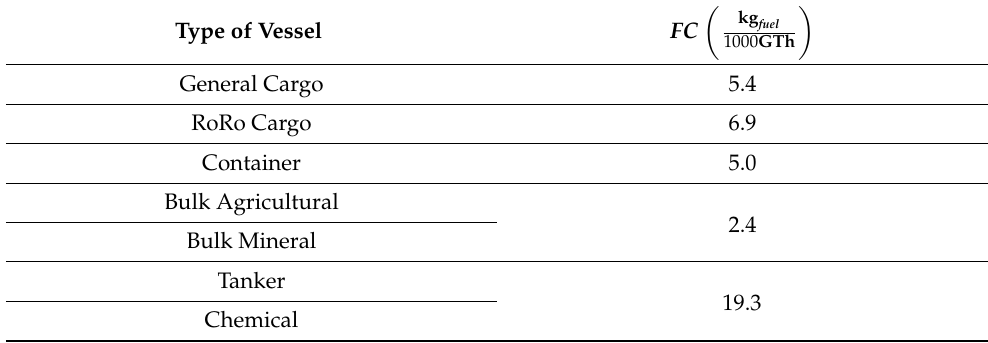
Table 6. Fuel consumption by type of ship in berthing position (Van der Gon and Hulskotte [15]).